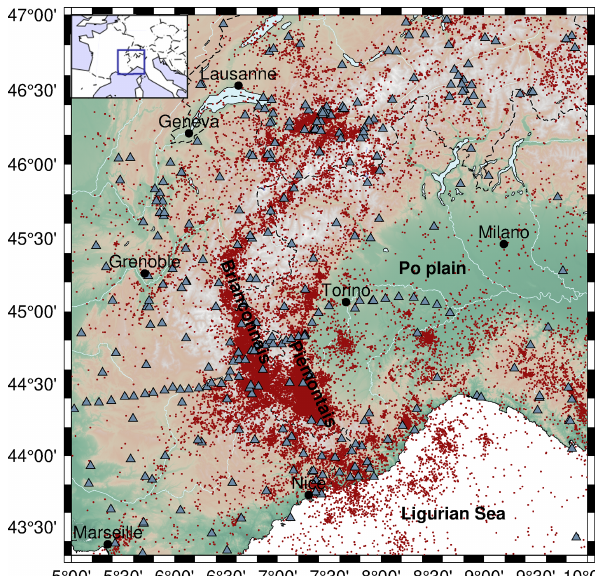
Figure 1. Map of the seismicity (red dots) encompassing the West- ern Alps, compiled in Potin (2016) from national and regional net- works seismic stations (triangles). The two major seismic arcs (Bri- ançonnais and Piémontais arcs) can be clearly identified in the seis-